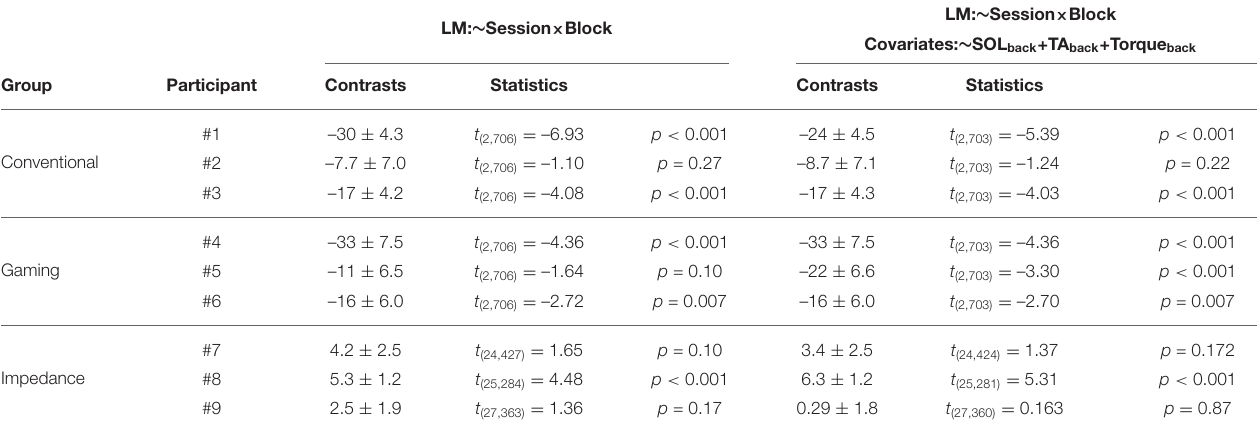
TABLE 1 | Contrasts between B1-5 and C4-C6 for the within-session SOL M1 effect without and with covariates.